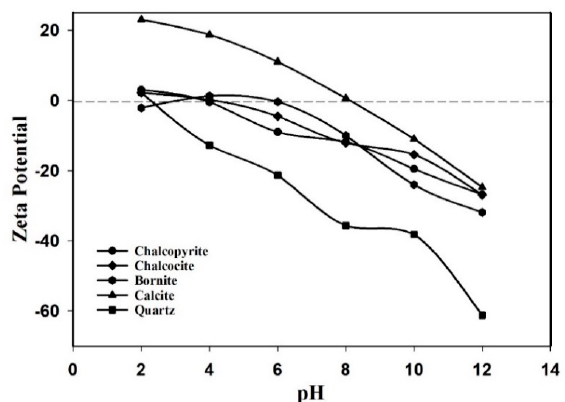
Figure 4. The zeta potential of copper minerals and gangue minerals in aqueous solution.